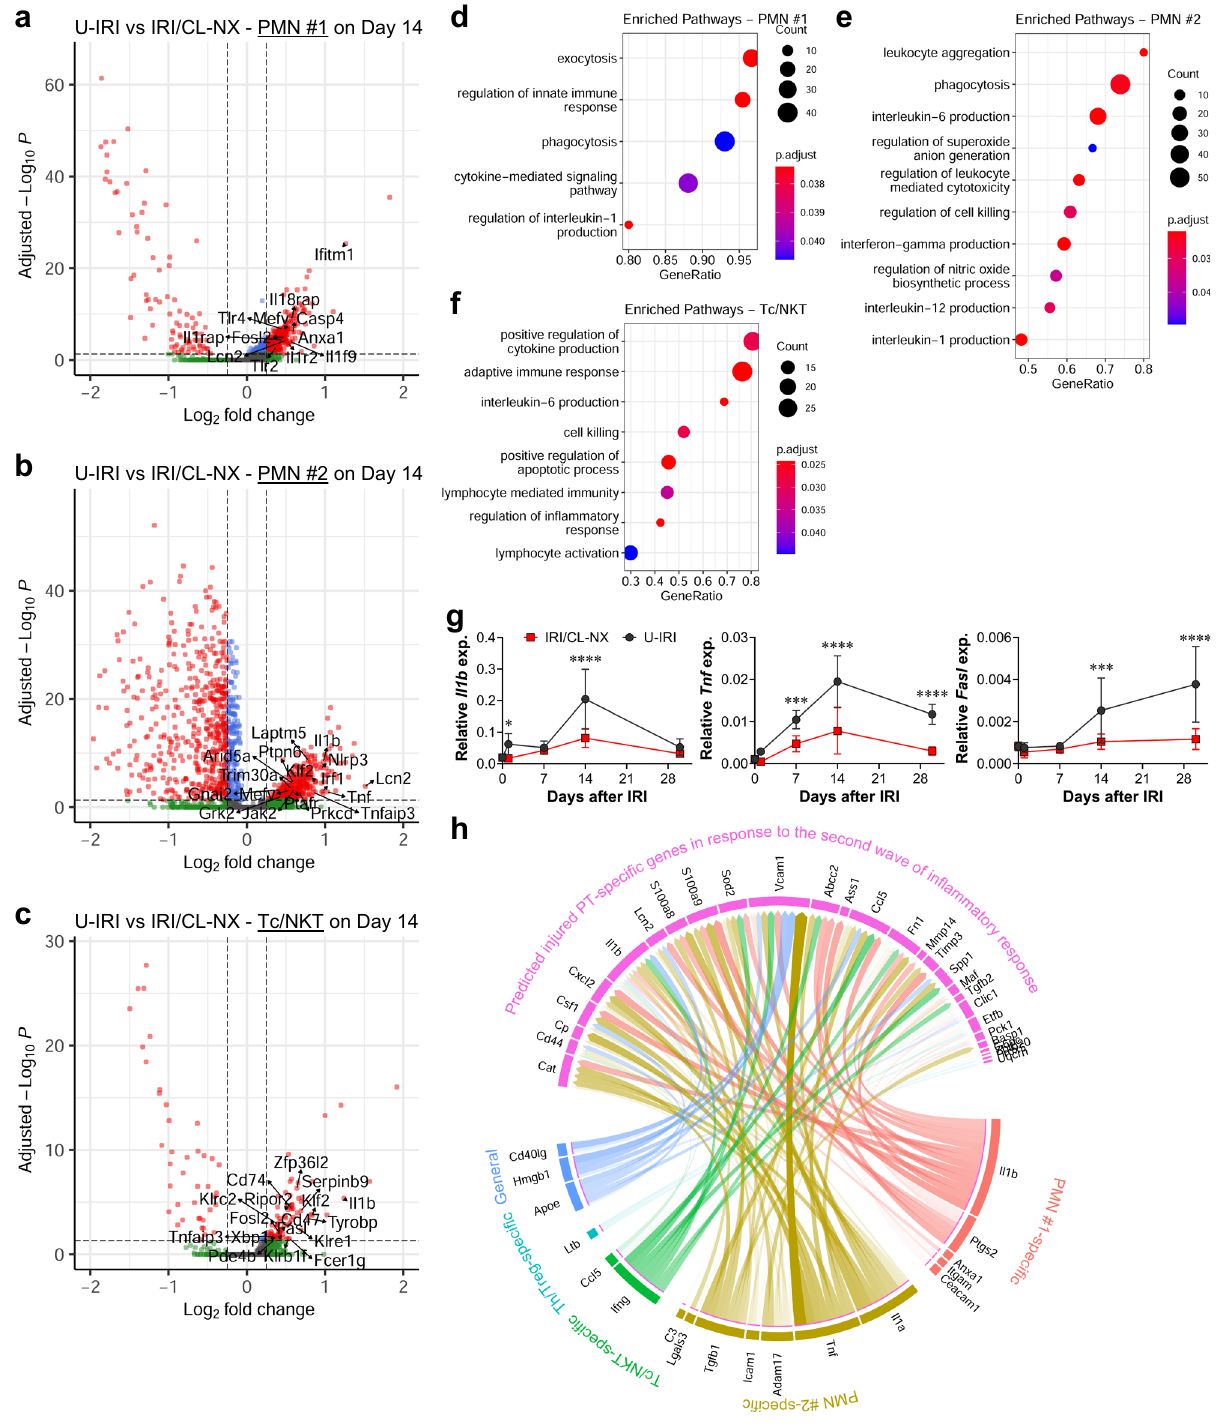
Fig. 7 | U-IRI promotes late PMN- and T- cell-mediated in fl ammation. Wild-type mice were subjected to 27min of ischemia/reperfusion injury (IRI) with con- tralateral nephrectomy (IRI/CL-NX) or unilateral IRI (U-IRI) and sacri fi ced on day 7, 14,and 30 after injury. Injured kidneys and normalcontrol kidneys were harvested for single-cell-RNA-sequencing analysis as shown in Fig. 3. a – c Volcano plots demonstratingdifferentialgeneexpressioninU-IRIcomparedtoIRI/CL-NXderived polymorphonuclear neutrophil cluster #1 (PMN #1) ( a ), PMN cluster #2 ( b ), and Cd8a+ cytotoxic T/natural killer T (Tc/NKT) cells ( c ) on day 14 after injury. d – f Basedondifferentiallyexpressedgenes(DEG)betweenU-IRIandIRI/CL-NXkidneys onday14afterinjury,thetoprelevantenrichedgeneontology(GO)termsforPMN